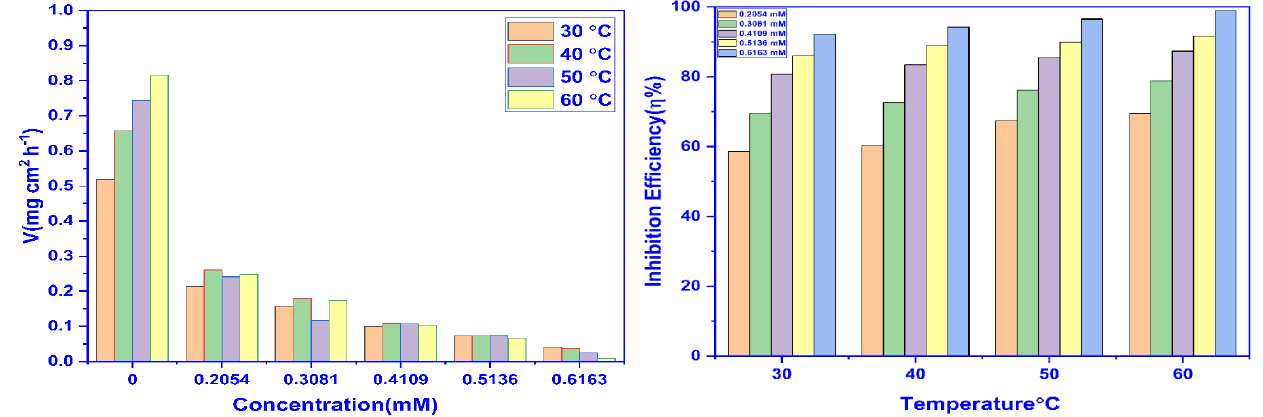
Figure 2. The impact of concentration ( Left ) and temperature ( Right ) on the corrosion inhibition potential of CMEA for MS in 1 M HCl.